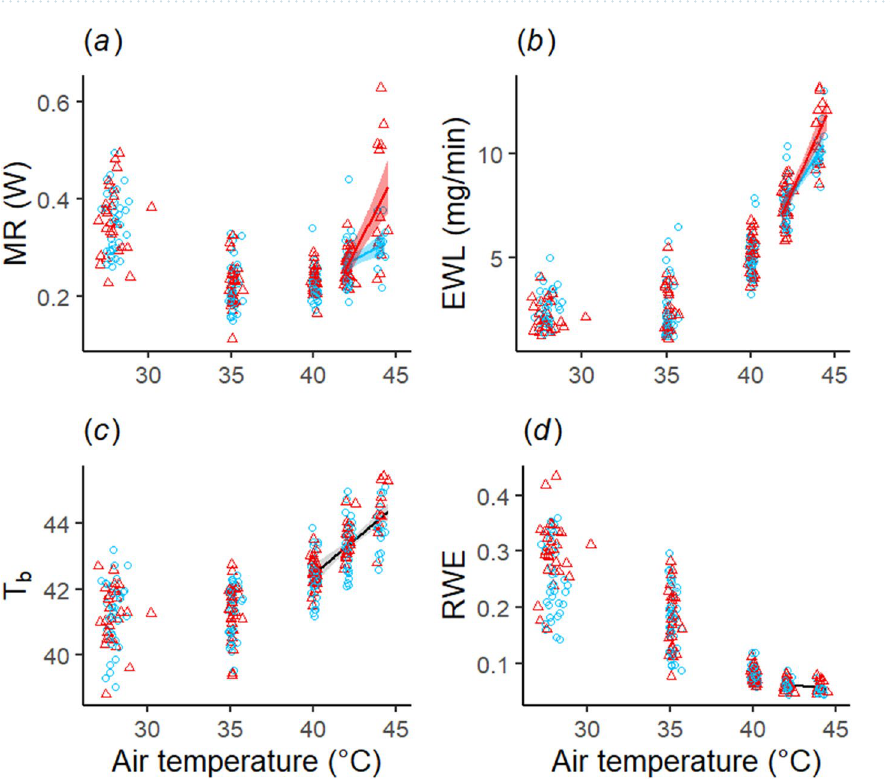
Figure 3. ( a ) Metabolic rate (MR), ( b ) evaporative water loss (EWL), ( c ) body temperature (T b ), and ( d ) relative water economy (RWE) of calm birds over a stepped profile of increasing T a . Segmented regressions identified a significant inflection point at T a = 41.2 ± 0.3 °C, 40.7 ± 0.3 °C, 40.2 ± 0.9 °C, and 40.8 ± 0.5 °C, for RMR, EWL, T b , and RWE. Regression lines display significant relationship from LMMs above inflection points, split by prenatal playback when significant: birds had been prenatally exposed to either heat-calls (red triangles) or control calls (blue